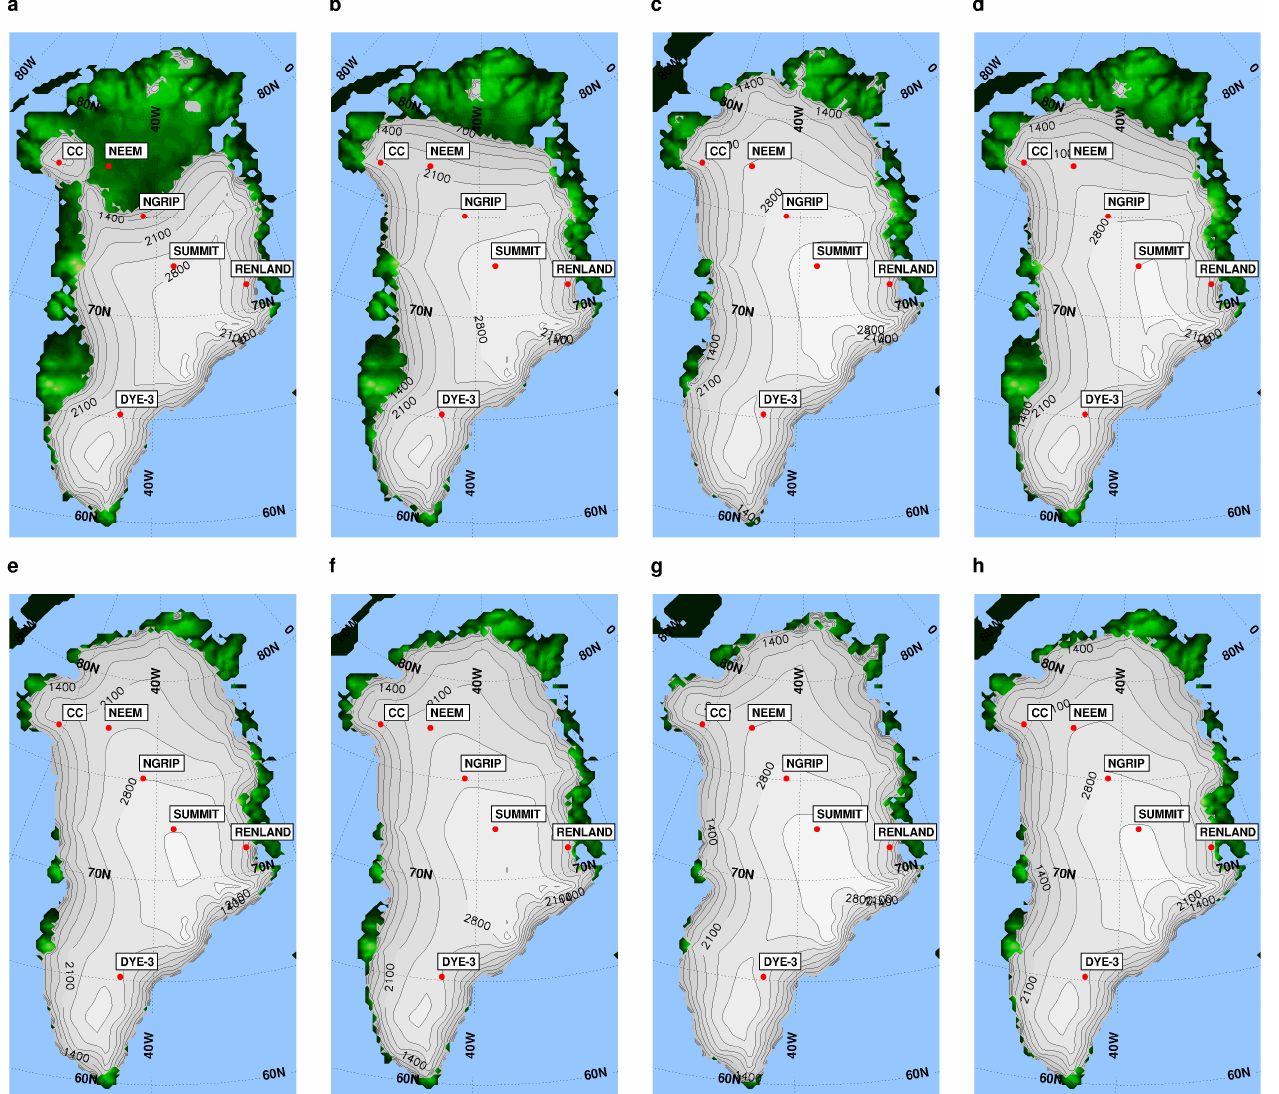
Fig. 8. Simulated range from the selected experiments for the minimum GrIS geometry during the LIG (a–d) and their respective modern-day GrIS geometries (e–h) . (a) Extent of the GrIS for the maximum contribution (at 121.0ka) to LIG sea level change ( + 3.8m), (b) the extent of the most likely contribution (at 123.5ka) to LIG sea level change ( + 1.5m), (c) the extent of the minimum contribution (at 125ka) to LIG sea level change ( + 0.4m) and (d) minimum extent for the ensemble member with a maximum GrIS contribution to LIG sea level rise closest to the peak of the probability density plot in Fig. 10a ( + 1.5m). Red spots show Greenland ice core